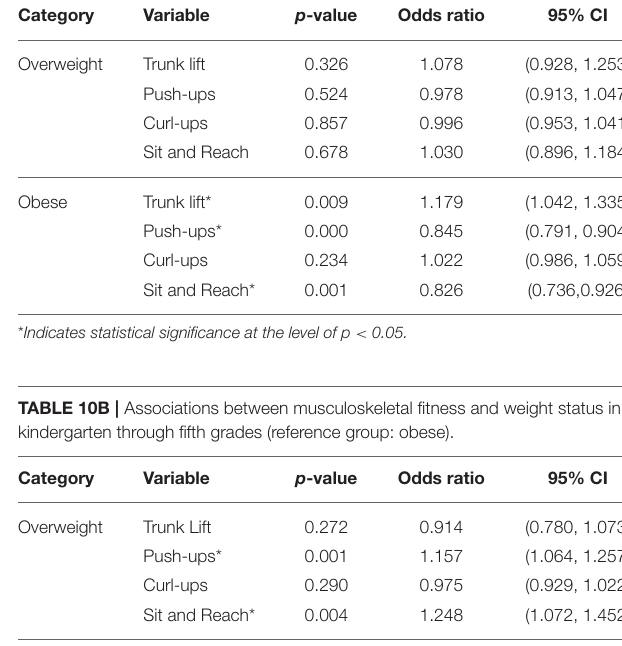
TABLE 10A | Associations between musculoskeletal fitness and weight status in kindergarten through fifth grades (reference group: healthy weight). Category Variable p -value Odds ratio 95% CI Overweight Trunk lift